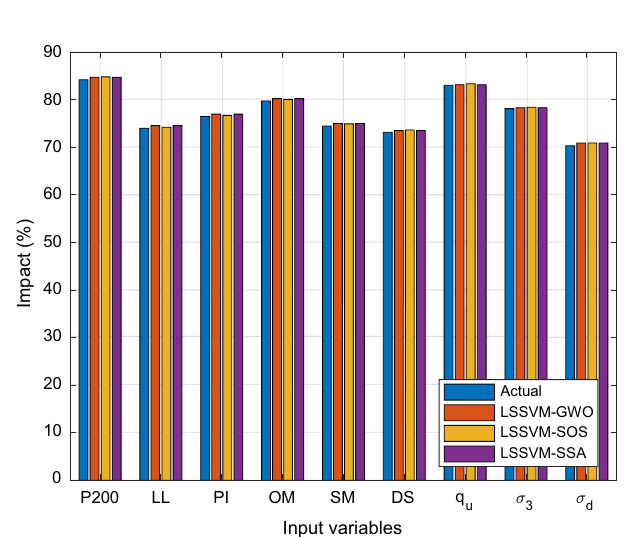
Figure 7. Impact of input variables on modelling Mr of subgrade